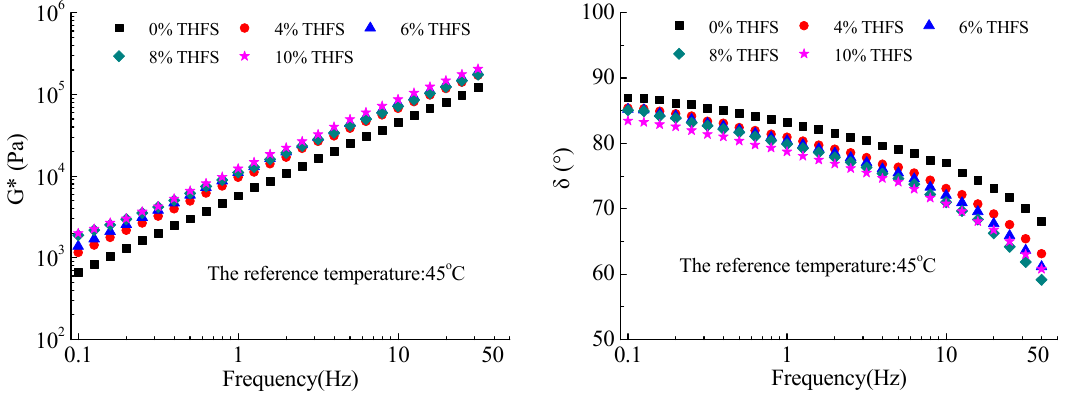
Figure 8. G* and δ Master Curves of Unaged Asphalt Binders over Frequencies.